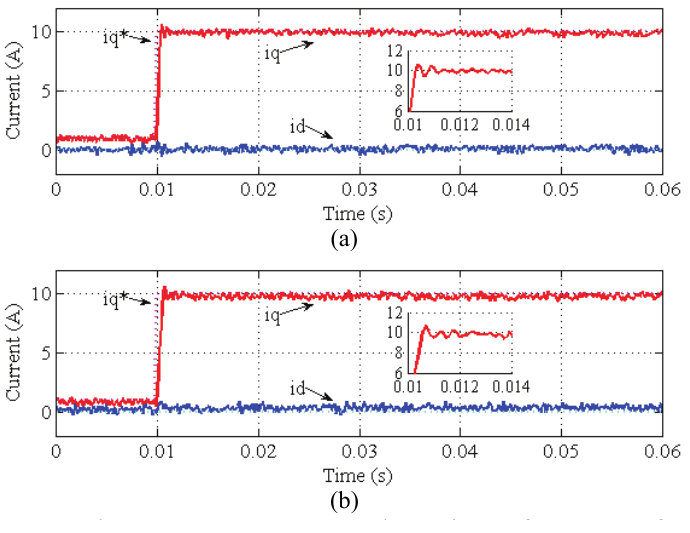
Fig. 17. Steady-state performance of the proposed method: (a) i dq at 100rpm; (b) i dq at 400rpm.